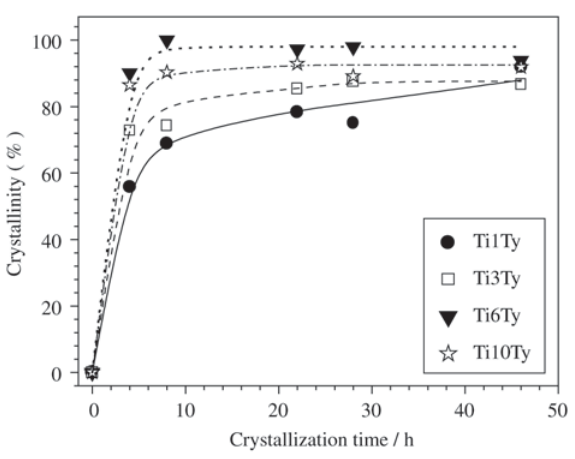
Figure 4. Crystallinity of the TAPO-5 samples as a function of the crystallization time.